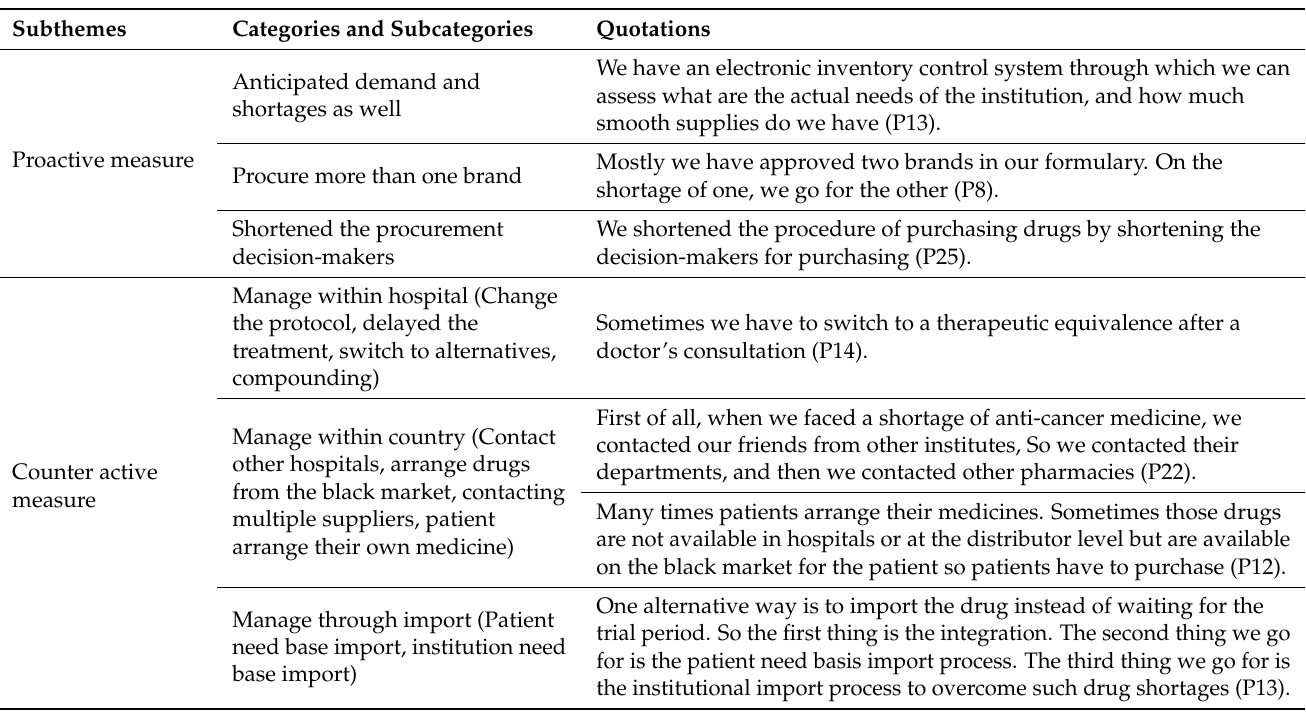
Table 5. Theme 4 Adopted mitigation strategies.